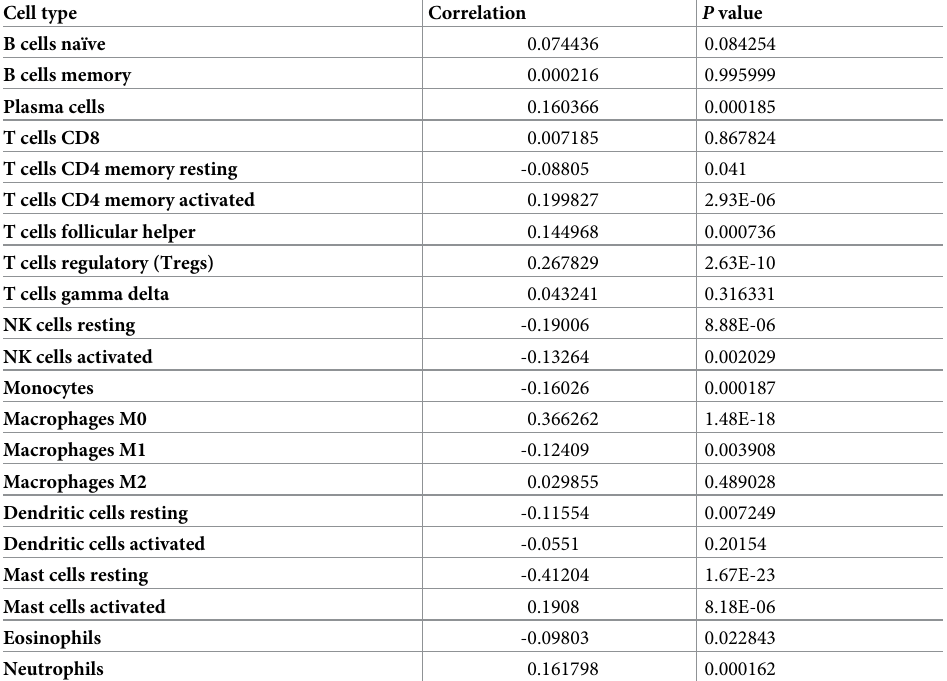
Table 4. Correlation analysis between PLAUR expression and the relative content of immune cell